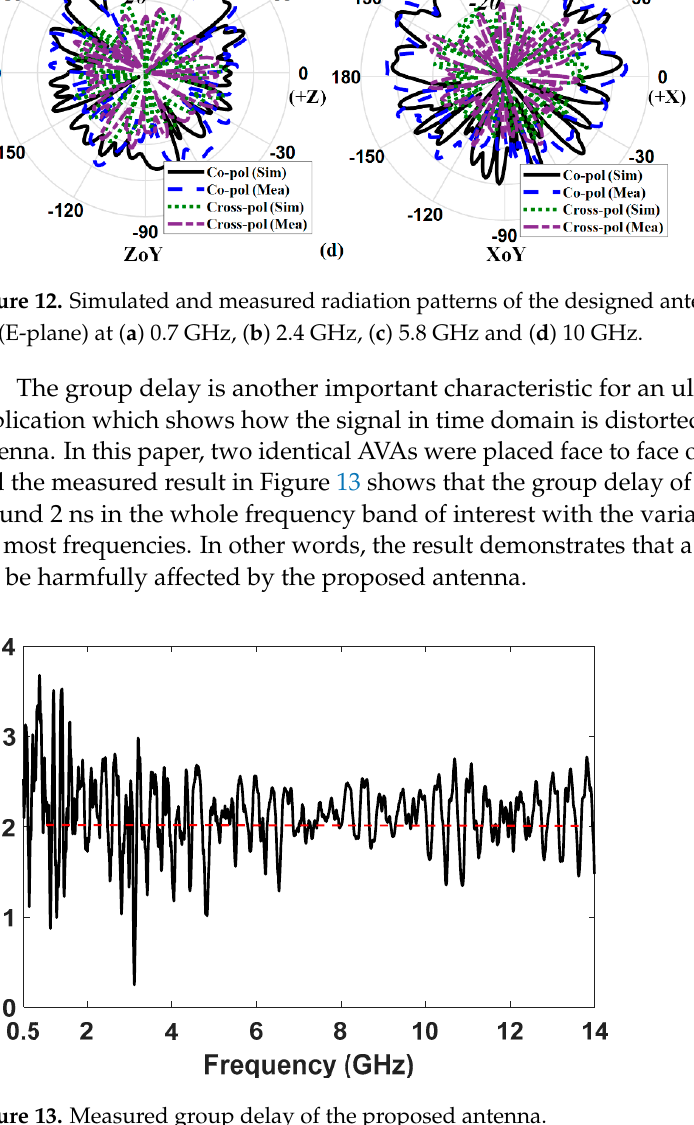
Figure 13. Measured group delay of the proposed antenna.